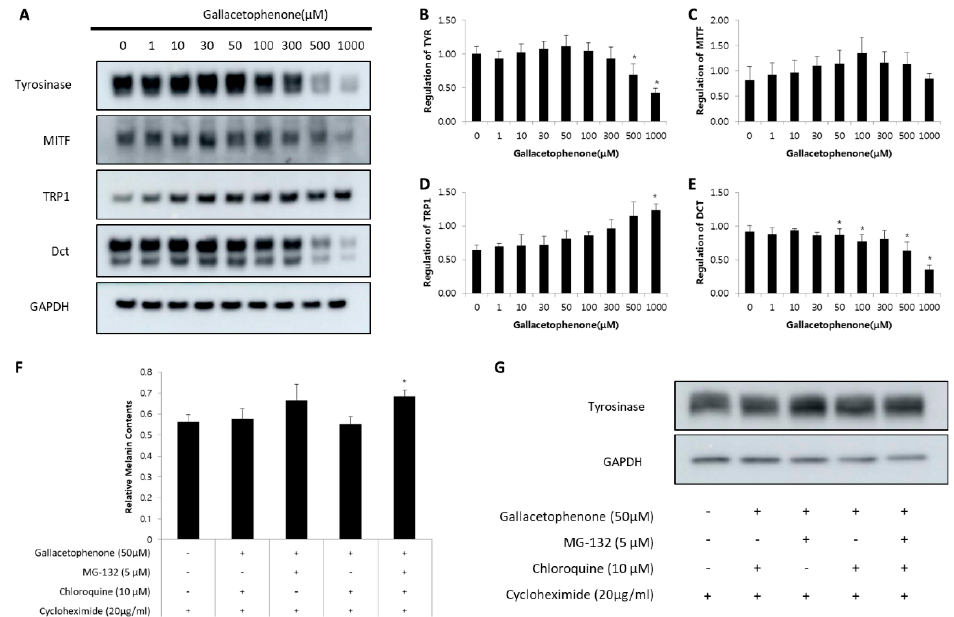
Figure 5. The expression level of melanogenic proteins and results of proteosomal inhibition assay. ( A , B ) Human epidermal melanocytes were treated with gallacetophenone in a dose-dependent manner. Signal intensity in the Western blot assay ( A ) was quantified using ImageJ software (National Institutes of Health, Bethesda, MD, USA) ( B – E ). To confirm the mechanism of gallacetophenone, the proteosomal inhibition assay was performed. The melanin contents were evaluated with proteosomal inhibitor MG-132 and lysosomal inhibitor chloroquine ( F ). The expression level of tyrosinase is shown in ( G ). Data are expressed as the mean ± SD of at least three independent measurements (* p < 0.05).